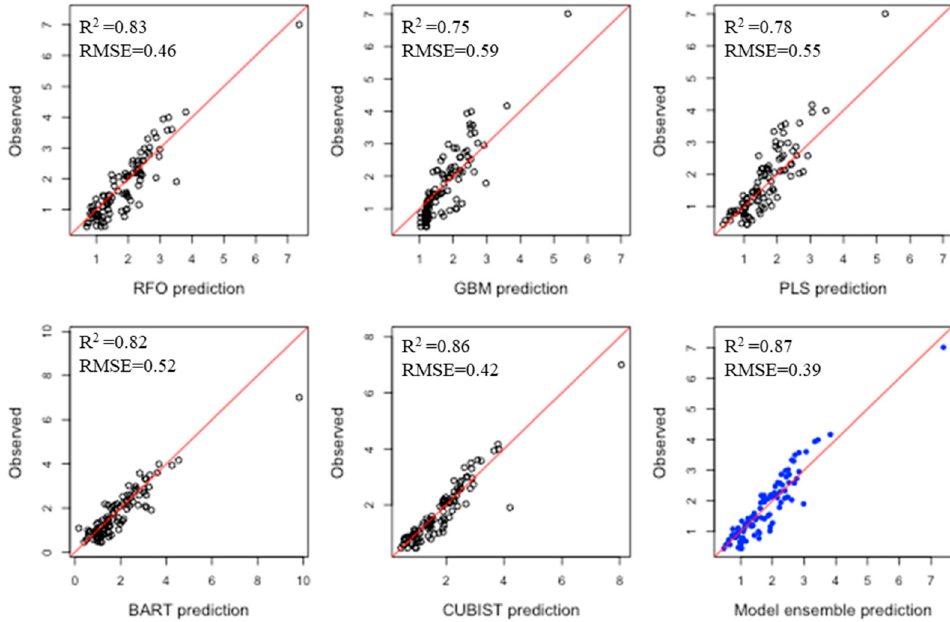
Figure 3. Scatter plot of observed and predicted total carbon content using RFO, GBM, PLS, BART, CUBIST and Total Ensemble.